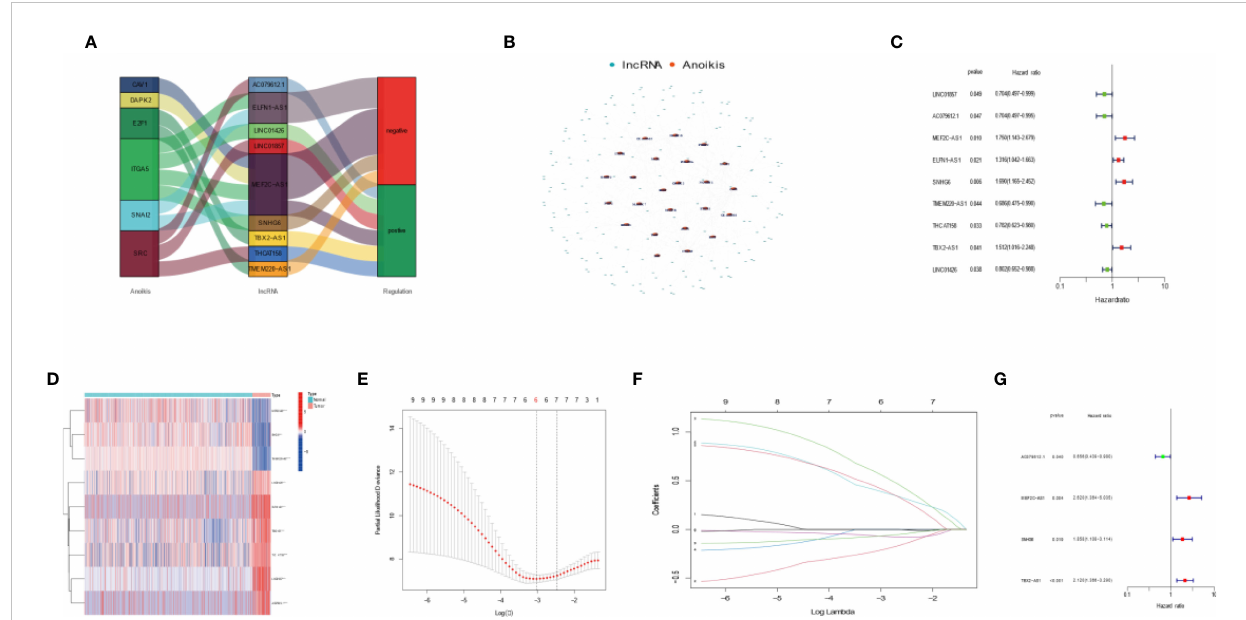
FIGURE 1 Developing a four anoikis-related long noncoding RNA (lncRNA) signature for osteosarcoma patients. (A) Sankey diagram highlighting the relationship between the anoikis genes and the anoikis-related lncRNAs. (B) Co-expression network showing the relationship between the expression of lncRNAs and that of Anoikis-associated genes. (C) Forest plot highlighting the univariate Cox regression analysis results. (D) Heatmap showing differential expression of Anoikis-related lncRNAs in tumor tissues and normal tissues. Red indicates high expression levels, while blue indicates low expression levels. (E) A general cross- validation curve of the paired likelihood deviance. (F) Elucidation for the LASSO coef fi cient pro fi les of the prognostic lncRNAs. (G) Forest plot highlighting the multiple Cox regression analysis